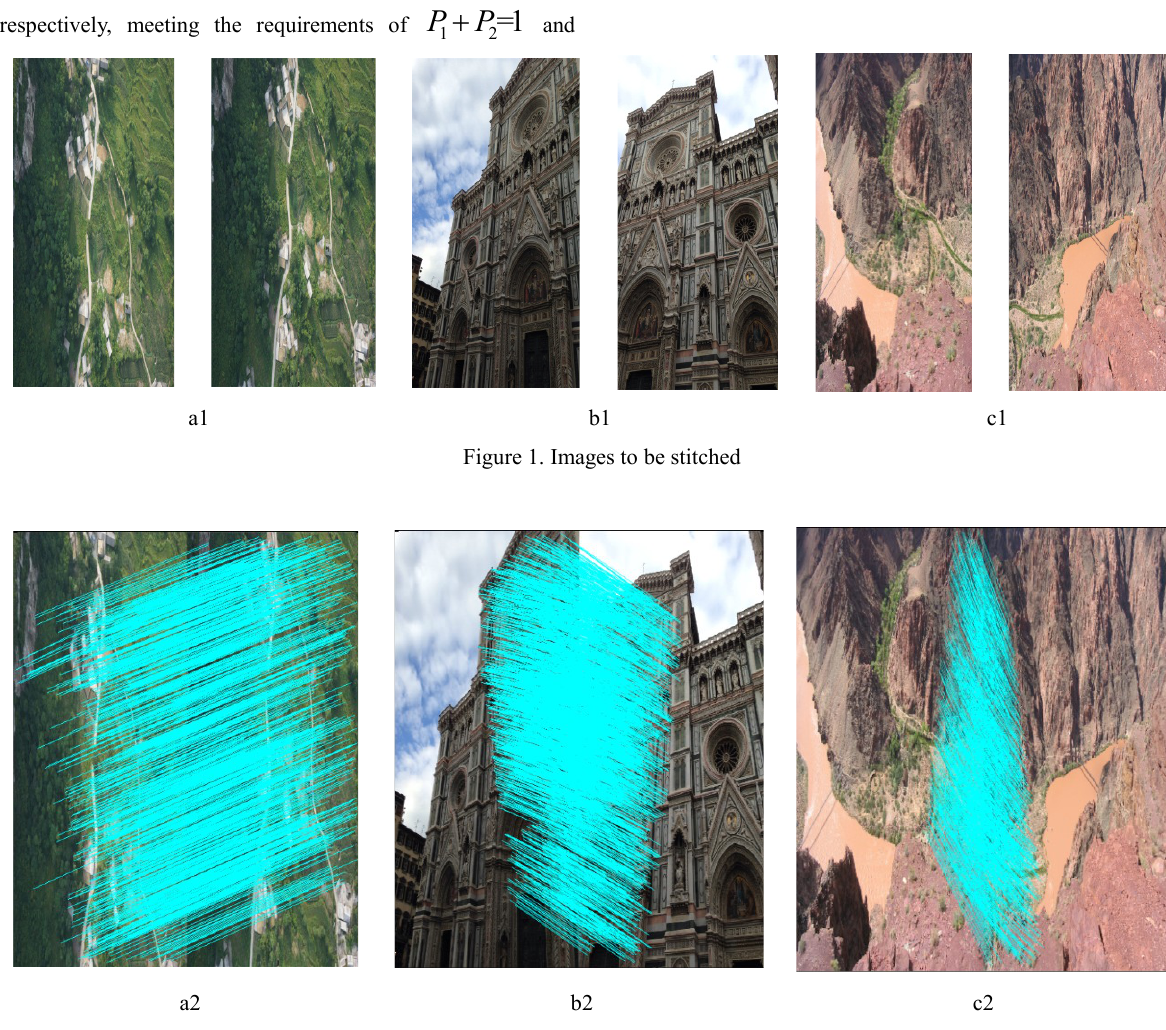
Figure 2. PCA-SIFT algorithm matching